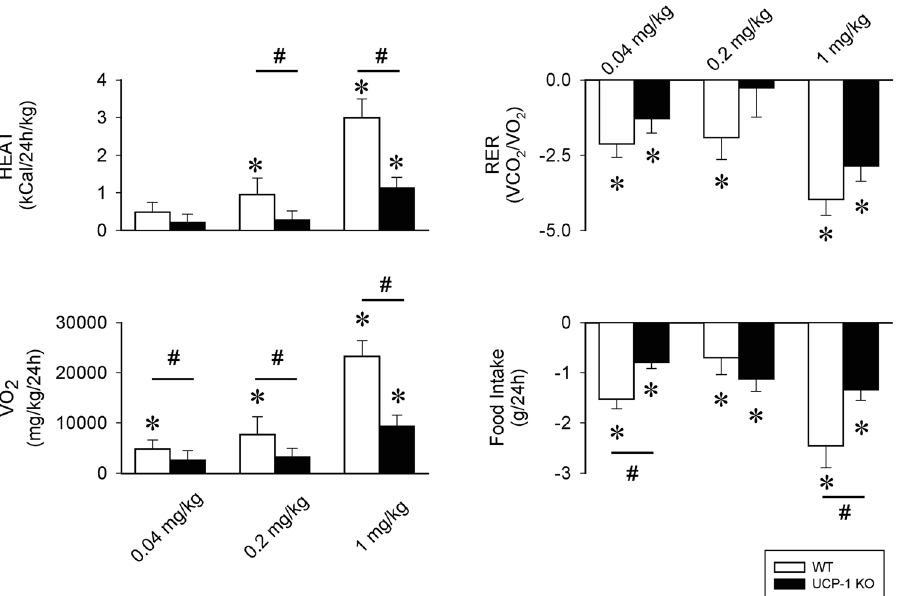
Figure 7. The effects of the selective β 3-AR agonist CL-316,243 on heat production (HEAT), O 2 consumption (VO 2 ), respiratory exchange ratio (RER) and 24-h food intake in WT (white bars) and UCP-1 KO mice (black bars). Data represent differences from baseline (vehicle). Error bars: standard error. Asterisk ( * ) denotes significant difference from baseline, # denotes significant difference between genotypes, p <